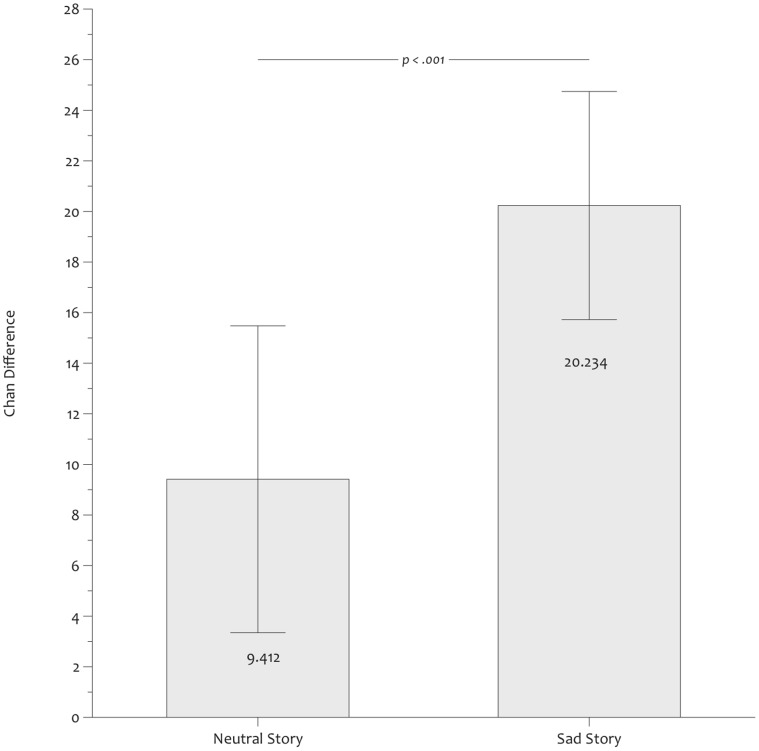
Chan differences.Differences between the proportions of “remember” responses in correct and incorrect completions in participants who performed above chance level in the completion task, represented separately for sad and neutral mood groups.